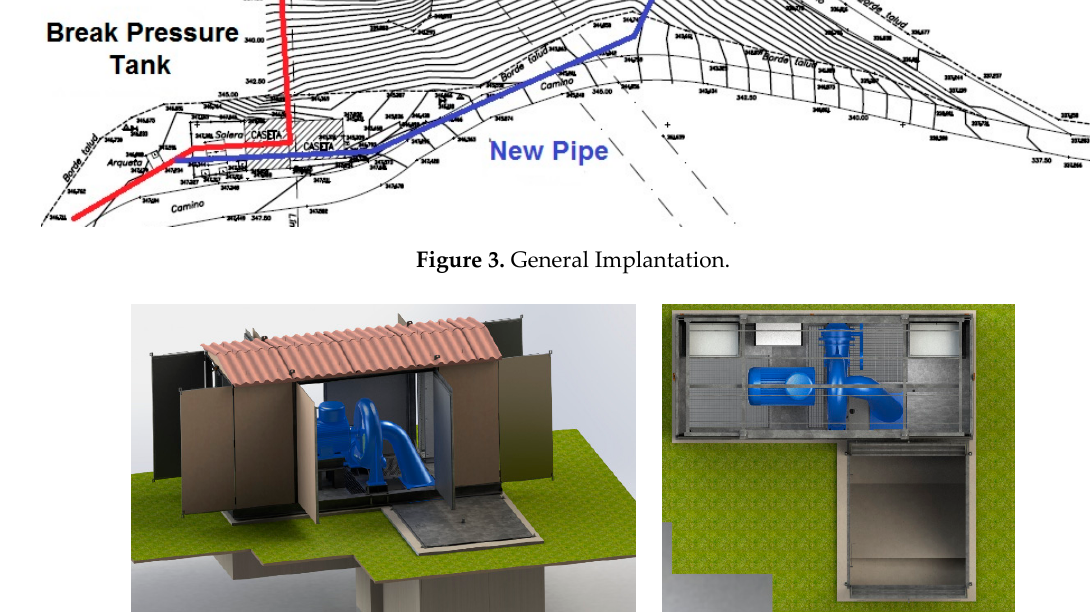
Figure 4. Designed device: ( a ) Turbine module; ( b ) Top view of the